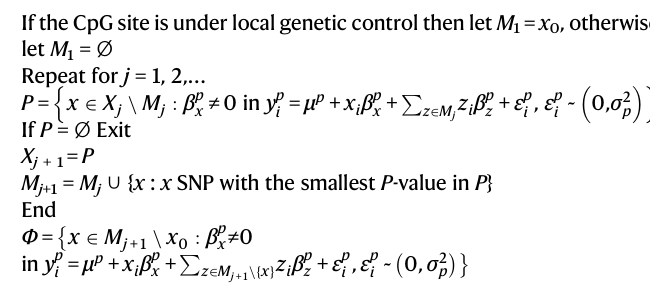
Algorithm 1 . Forming a set of remote independently associated SNPs with a CpG